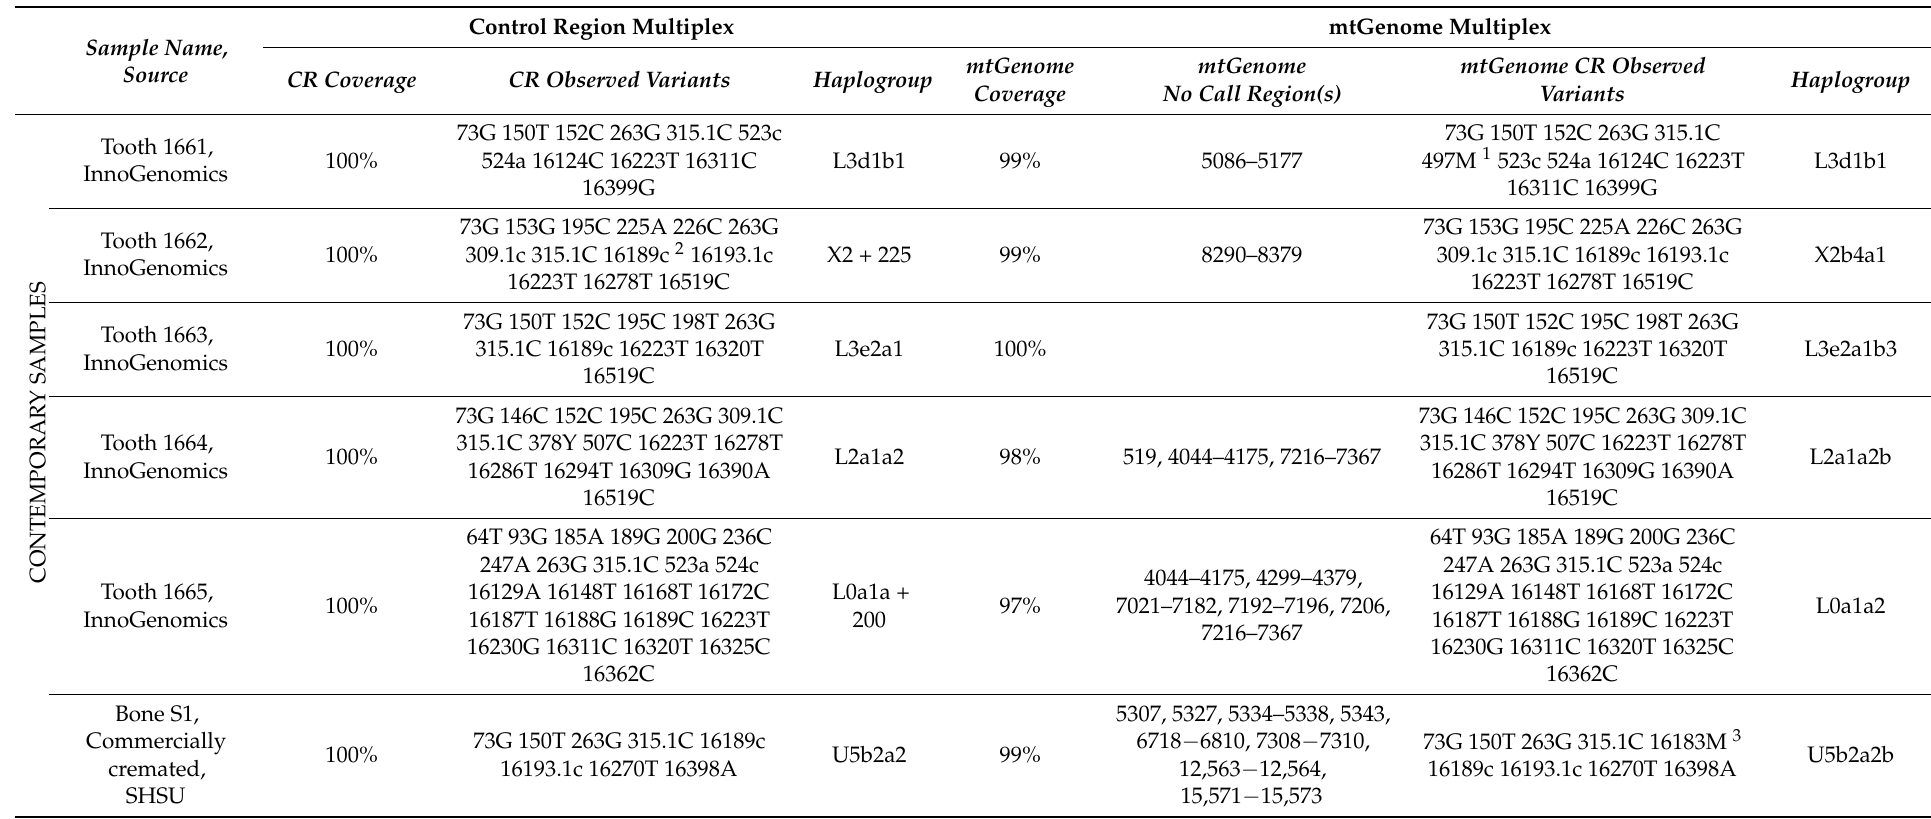
Table 1. Mock casework human remains: control region and mtGenome coverage, variants and European DNA Profiling Group (EDNAP) mtDNA population (EMPOP) haplogrouping, control region concordance between mtDNA